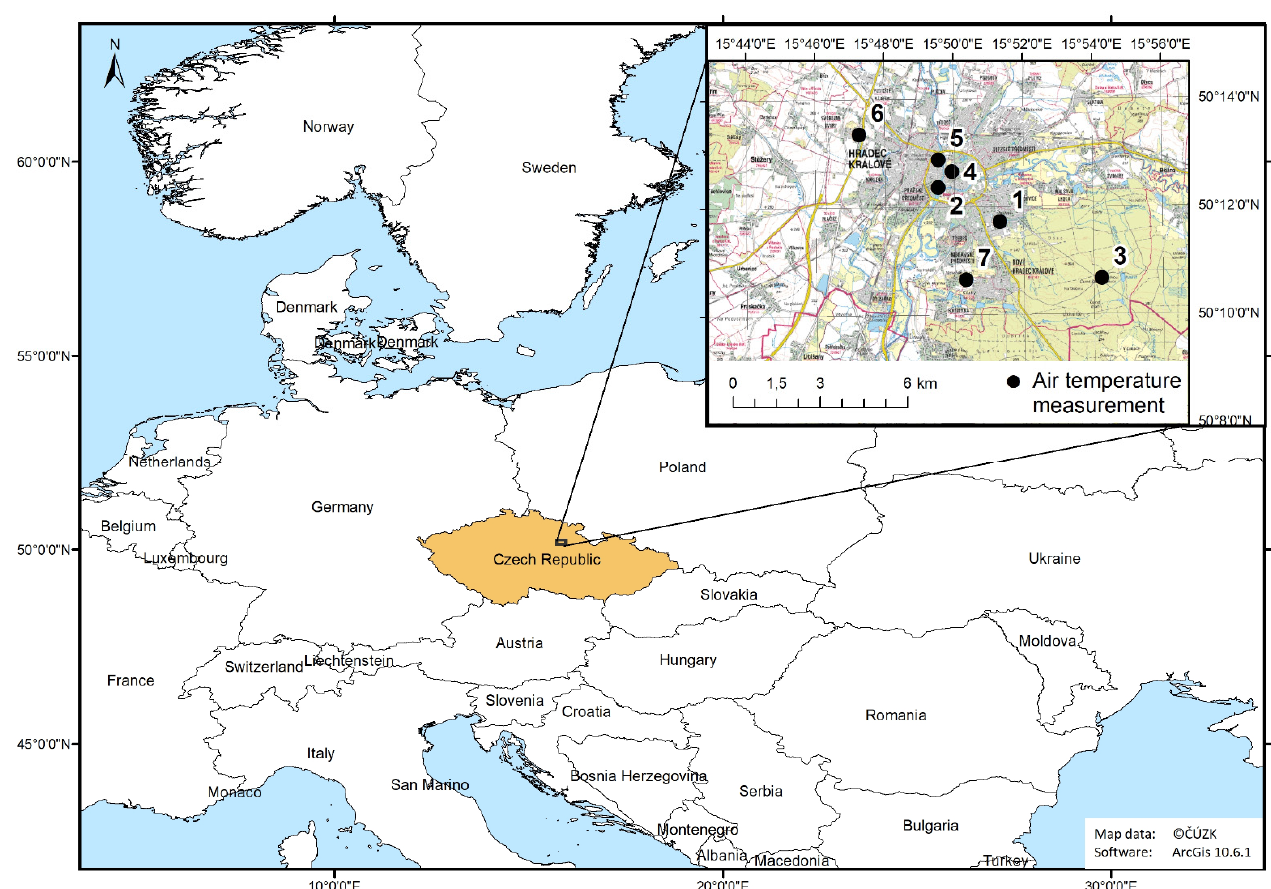
Figure 2. Location of the study area. Map data: © Czech Office for Surveying, Mapping and Cadastre ( Č ÚZK).